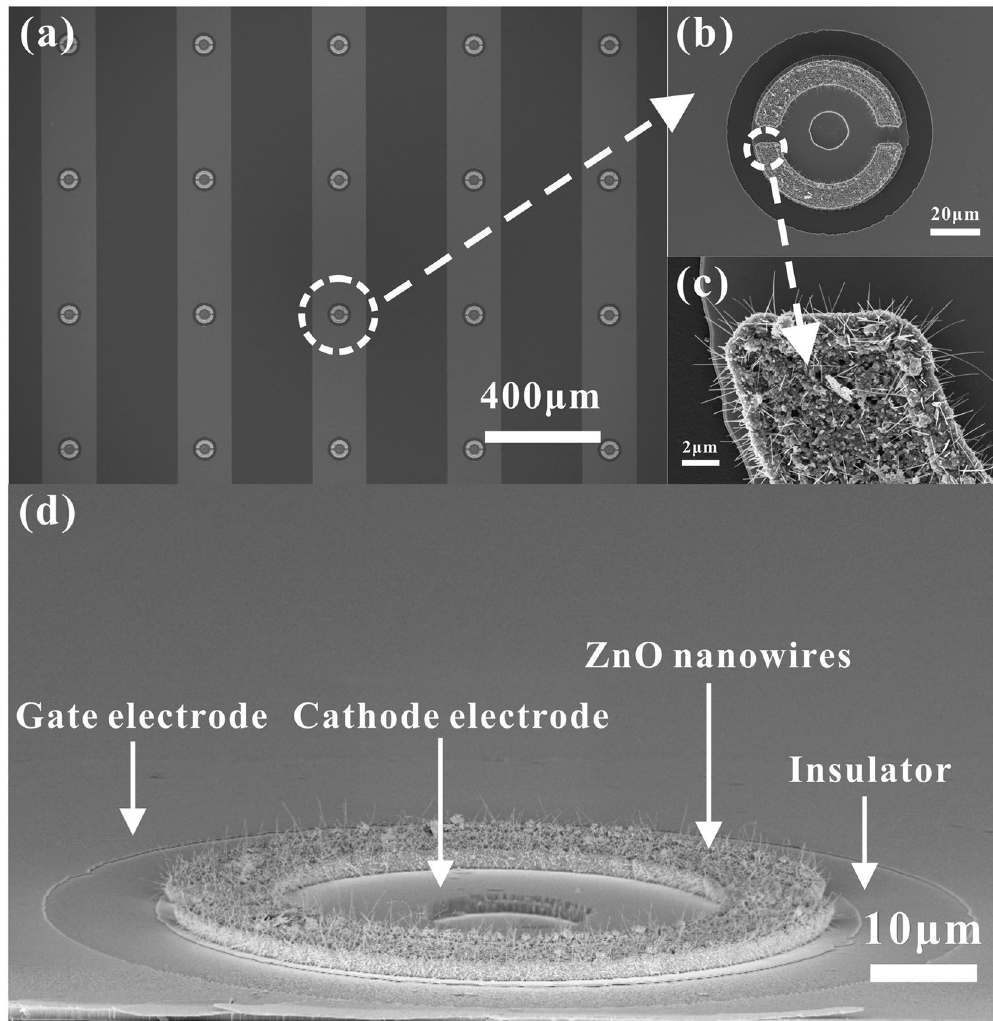
morphologies in the ZnO nanowire pad; ( d ) cross-sectional SEM image of the ZnO nanowire pad in an individually addressable